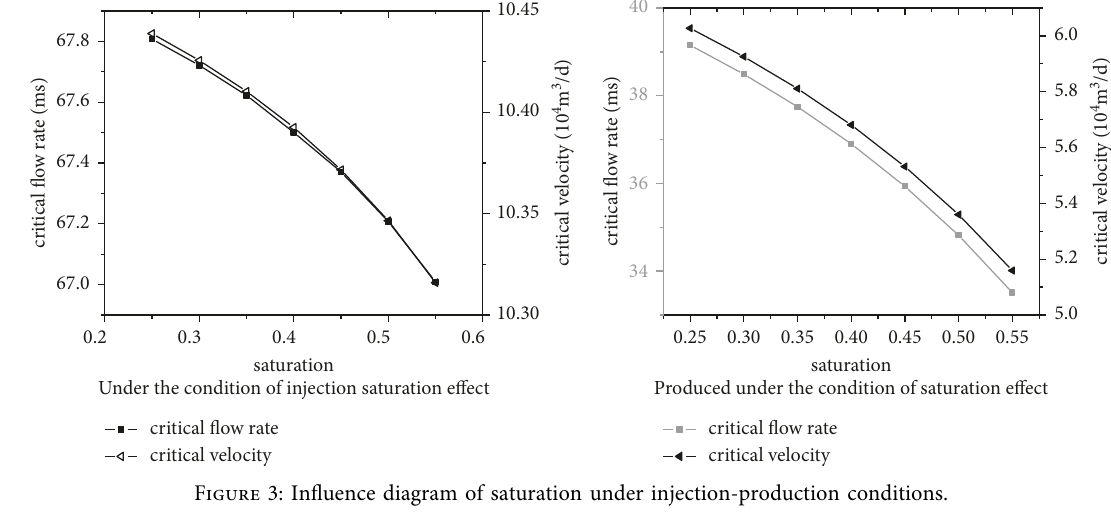
Figure 3: Influence diagram of saturation under injection-production conditions.